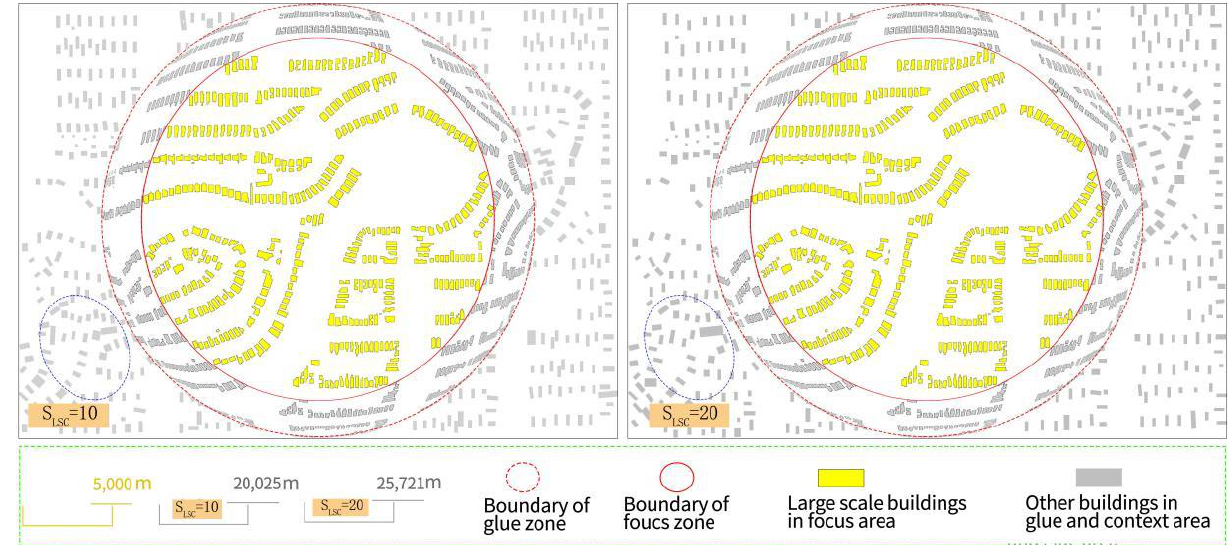
Figure 17. Typification comparison of different aperture superpixel LSC sizes.